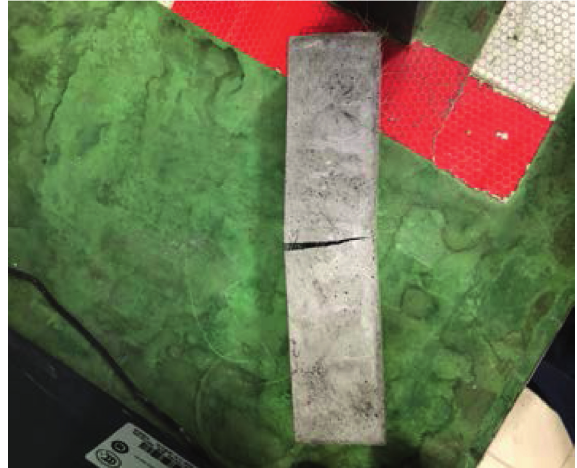
Figure 7: Appearance of the specimen after flexural failure.